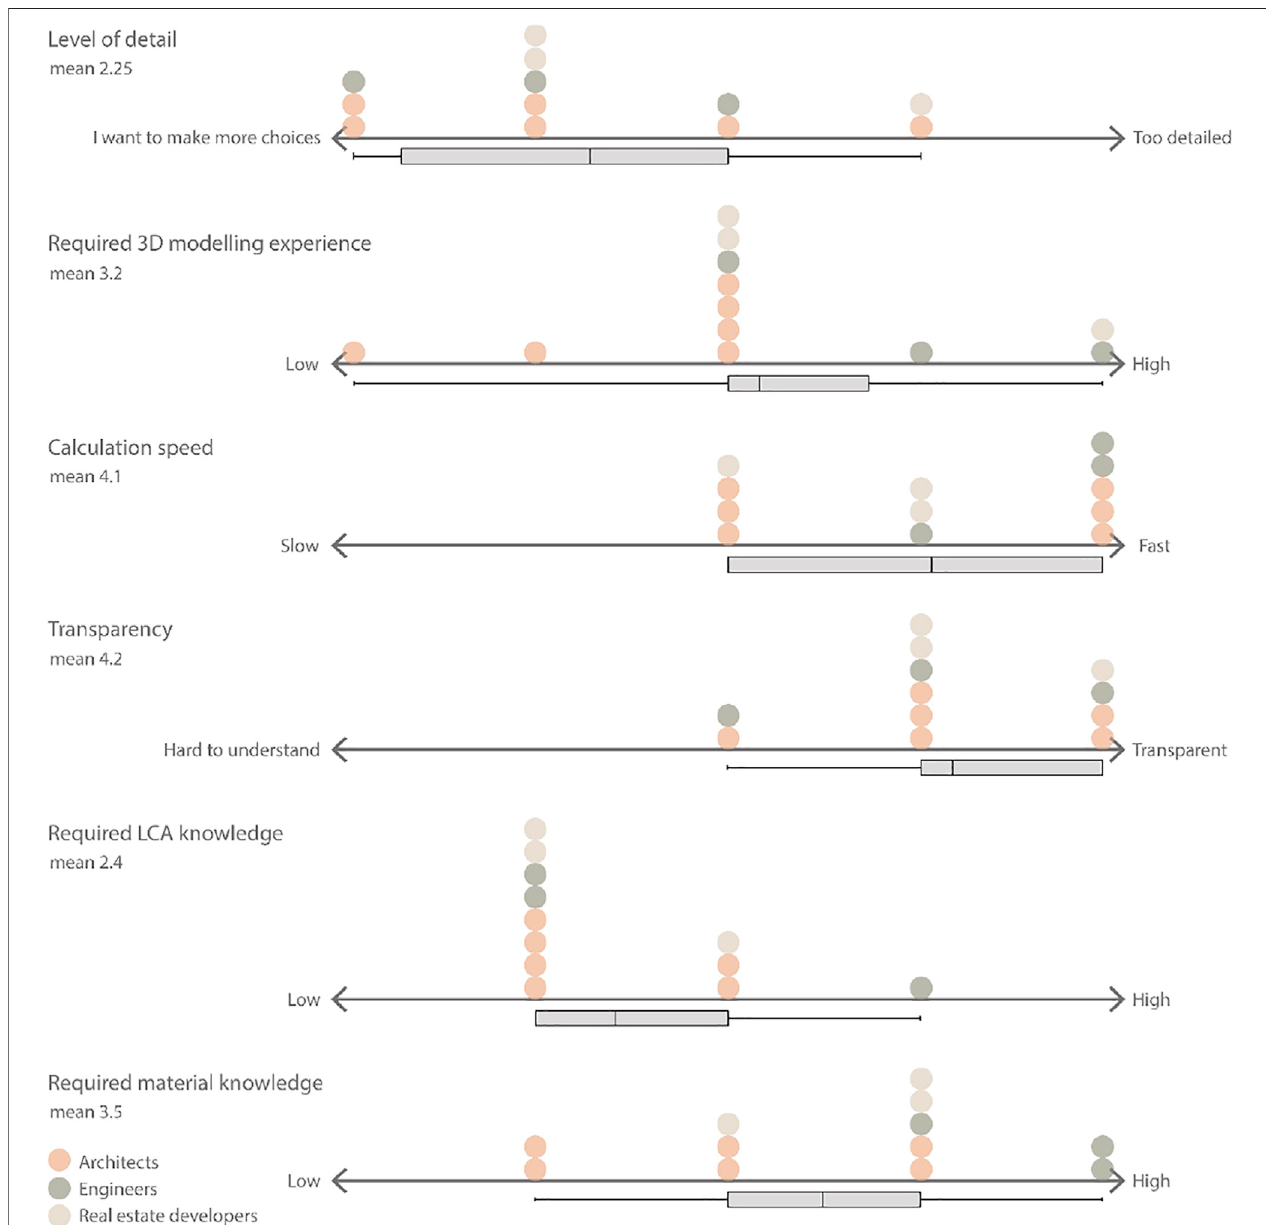
FIGURE 8 | User rating with individual answers and box plots with mean, minimum, and maximum values and the 25 and 75 percentiles for each question.